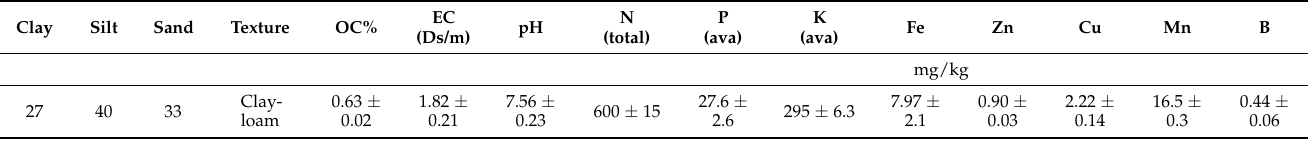
Table 10. Physical and chemical properties of soil in experimental field at Karaj,